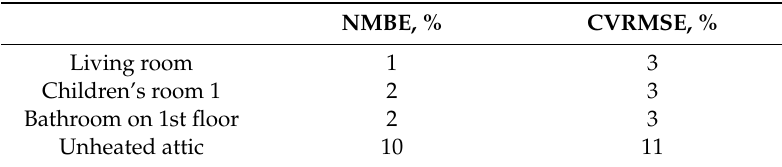
Table 2. Values of Normalized Mean Bias Error (NMBE) and Coefficient of Variation of Root Mean Squared Error (CVRMSE) indicators after the model calibration.